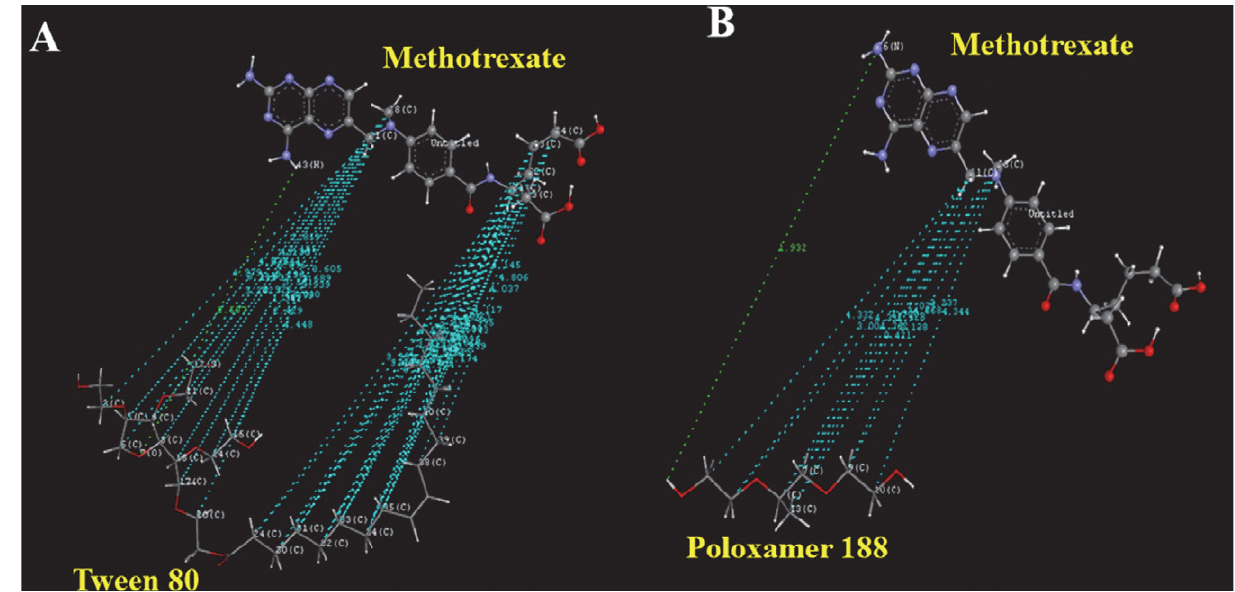
size of MTX-NS an Ishikawa diagram was established (Figure 2). As a result of risk analysis, the 8 possible